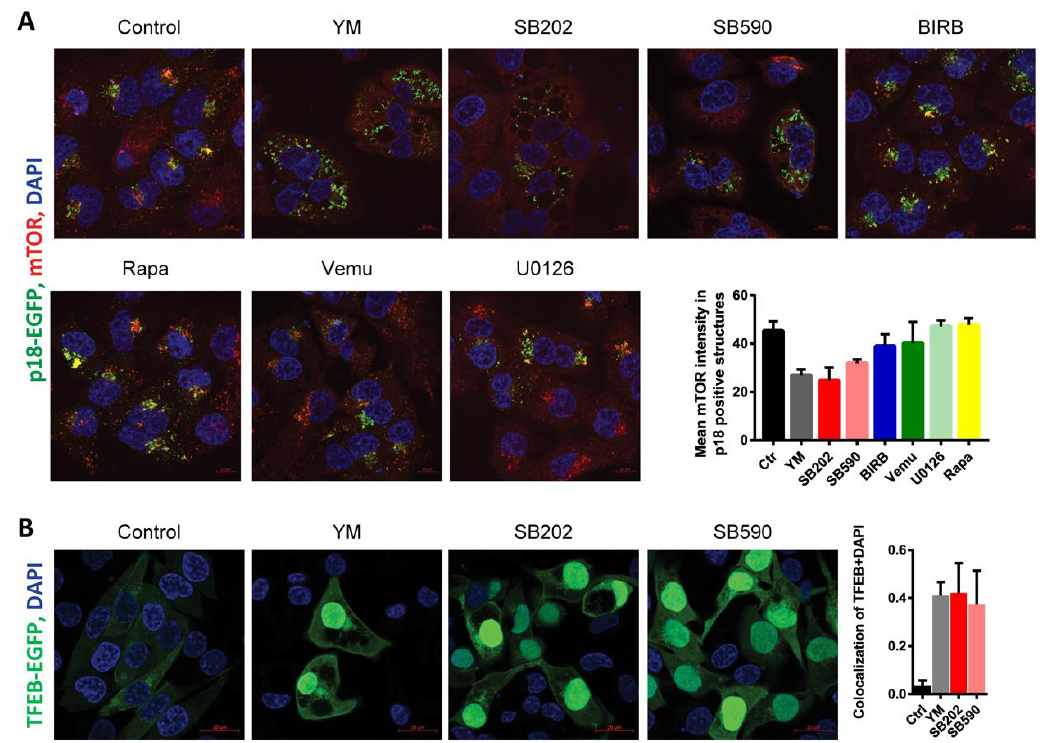
Figure 5. Pyridinyl imidazole compounds induce the delocalization of mechanistic target of rapamycin (mTOR) kinase from lysosomes in melanoma cells. ( A ) EGFP-labeled p18 / LAMTOR1, endogenous mTOR, and nuclei (DAPI) were visualized by confocal fluorescence microscopy in A375 cells treated with YM201636 (YM; 1 µ M), SB202190 (SB202; 15 µ M), SB590885 (SB590; 5 µ M), BIRB796 (BIRB; 15 µ M), Vemurafenib (Vemu; 1 µ M), U0126 (10 µ M), and Rapamycin (Rapa; 200 nM). Scale bar: 10 µ m. The co-occurrence of two fluorescent signals (p18 / LAMTOR1-EGFP and endogenous mTOR) was quantified using ImageJ / Fiji. Measurements of three pictures from the same experiment were used for analysis. Three independent experiments showed similar results. ( B ) A375 cells were transiently transfected with a plasmid construct encoding EGFP-tagged transcription factor EB (TFEB) and treated for 24 h with YM201636 (YM; 1 µ M), SB202190 (SB202; 15 µ M), and SB590885 (SB590; 5 µ M) and the nuclear translocation of TFEB was analyzed using confocal fluorescence microscopy. Scale bar: 20 µ m. Colocalization of TFEB and DAPI was quantified using ImageJ / Fiji software (Pearson’s correlation coe ffi cient), and the results were plotted in a graph. Similar results were obtained in three independent experiments.